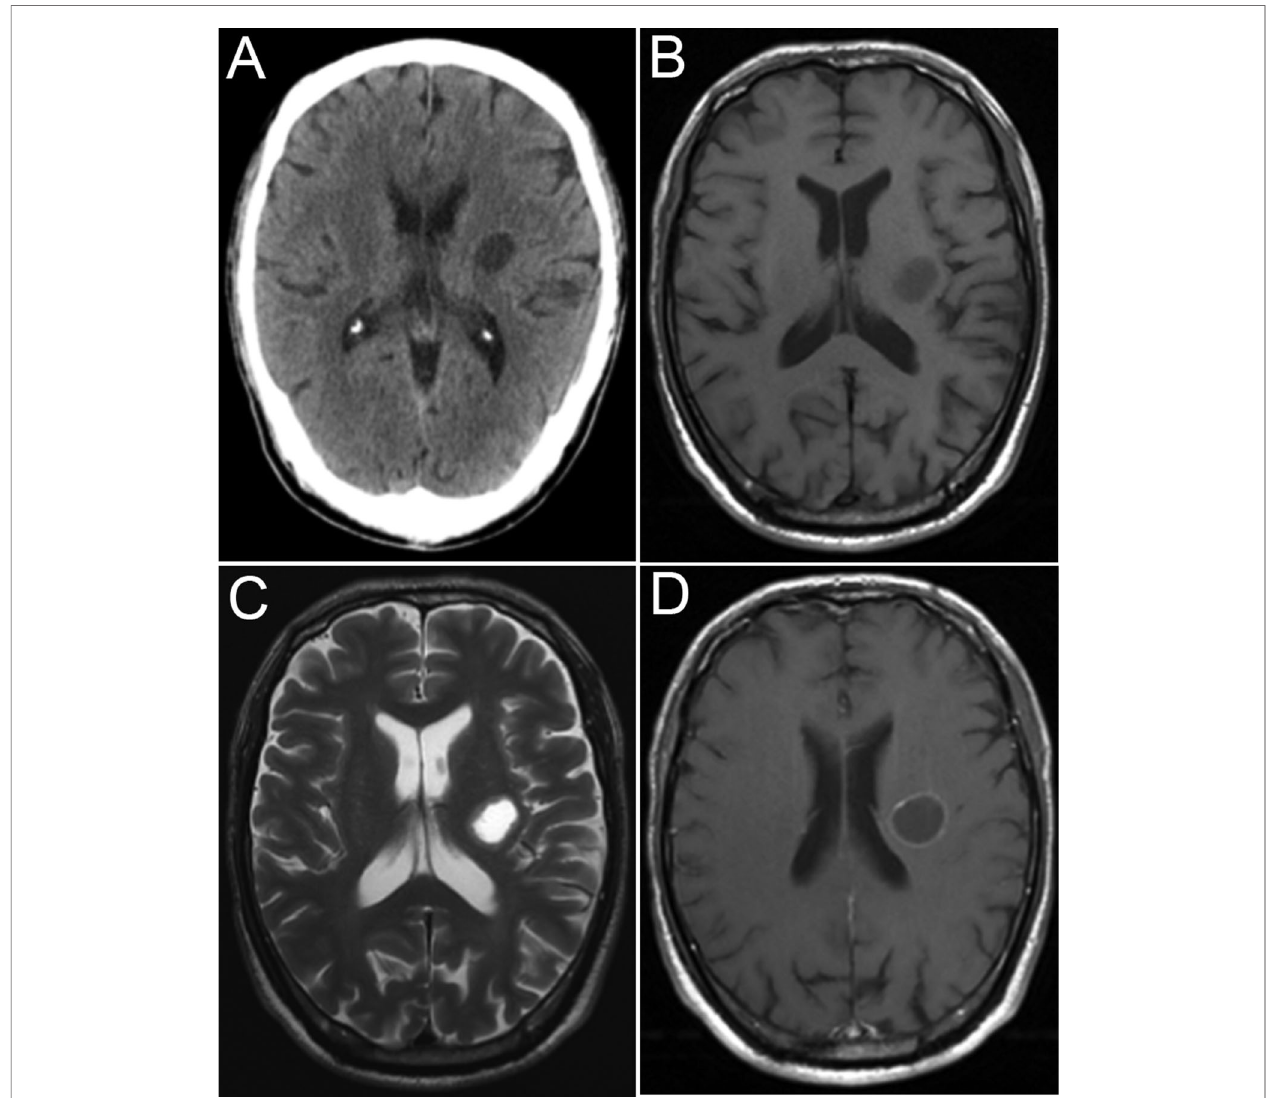
FIGURE 1 | Image at admission. CT image ( A ), MR T1 image ( B ), MR T2 image ( C ), and MR T1-weighted image ( D